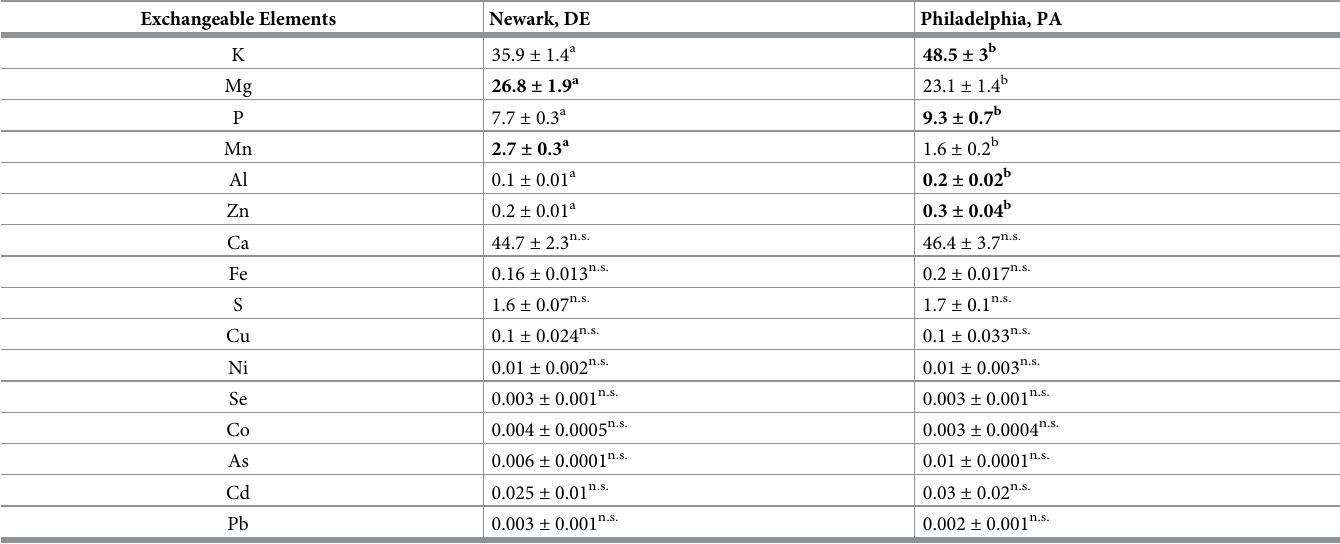
Table 3. Concentrations of exchangeable foliar elements ( μ mol g -1 FW) in red maples from five forests each in Newark, DE (n = 39) and Philadelphia, PA (n = 38). Exchangeable Elements